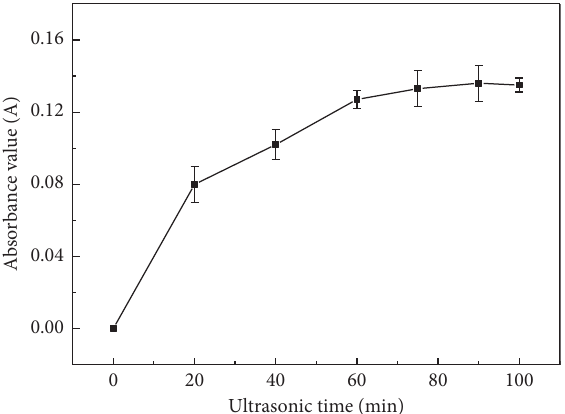
Figure 9: The effect of ultrasonic time on intermediate quantity.